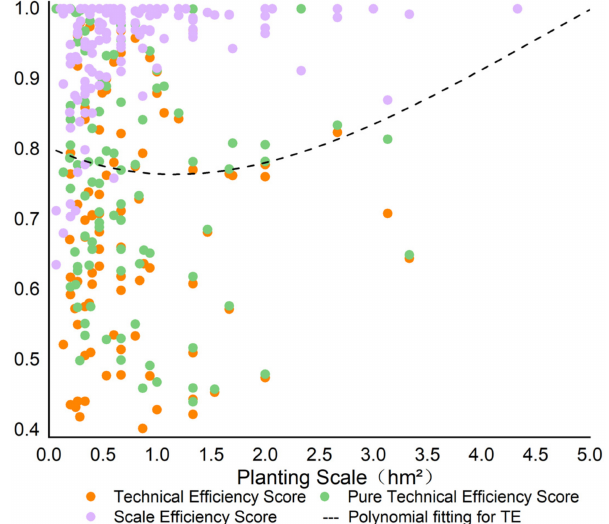
Figure 2. Relationship between technical, pure technical, and scale efficiency and the planting scale.